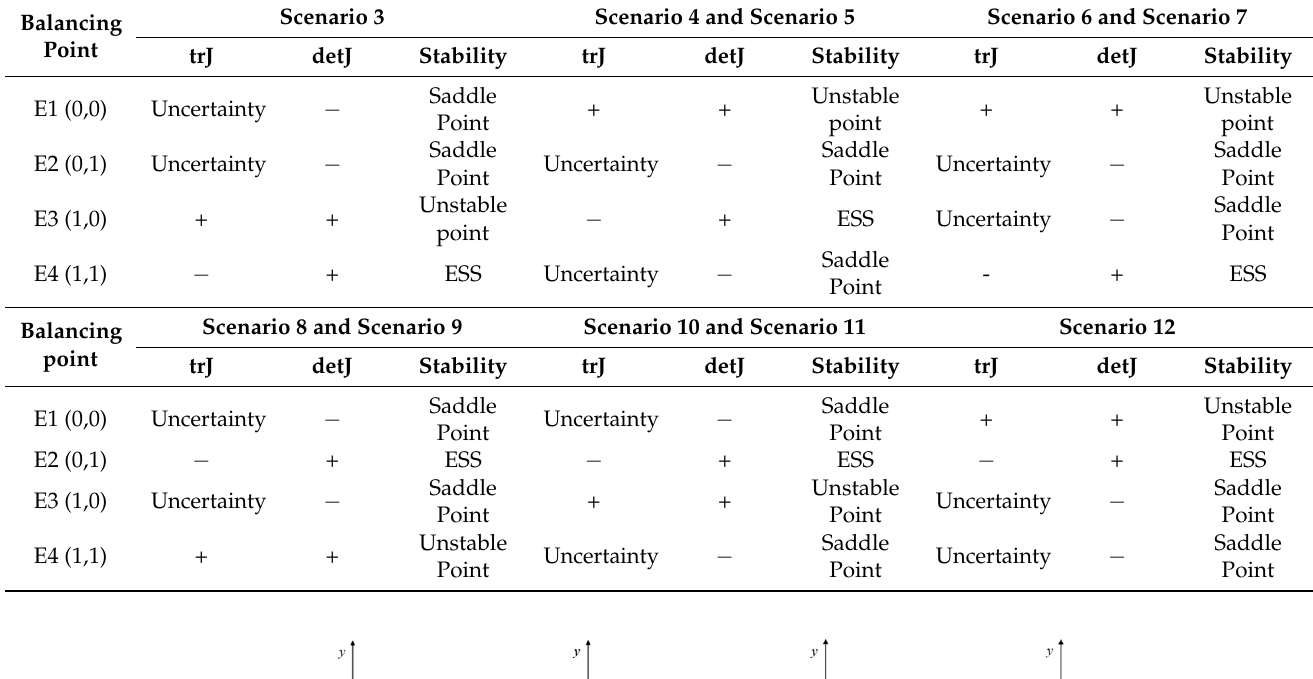
Table 6. Asymptotic stability analysis of the local equilibrium points under Scenarios 3–12.